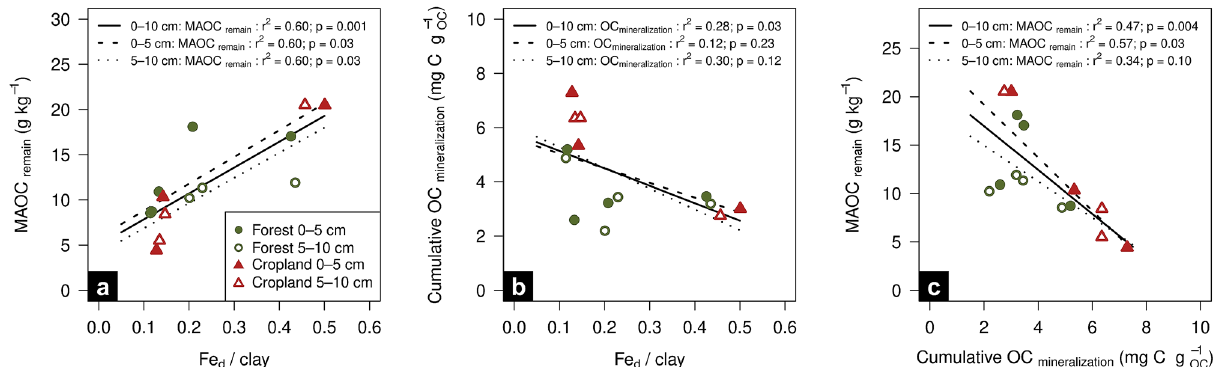
Figure 5. ( a ) MAOC content resistant to chemical oxidation with 6% NaOCl (MAOC remain ) in relation to the Fe d to aluminous clay ratio. ( b ) Cumulative OC mineralization after 50 days of incubation in relation to the Fe d to aluminous clay ratio. ( c ) MAOC remain content related to the cumulative OC mineralization. Aluminous clay represents the weight sum of kaolinite and gibbsite present in the < 2-µm fraction and Fe d denotes the content of total pedogenic Fe extractable by dithionite-citrate-bicarbonate. All regression models are provided in Table